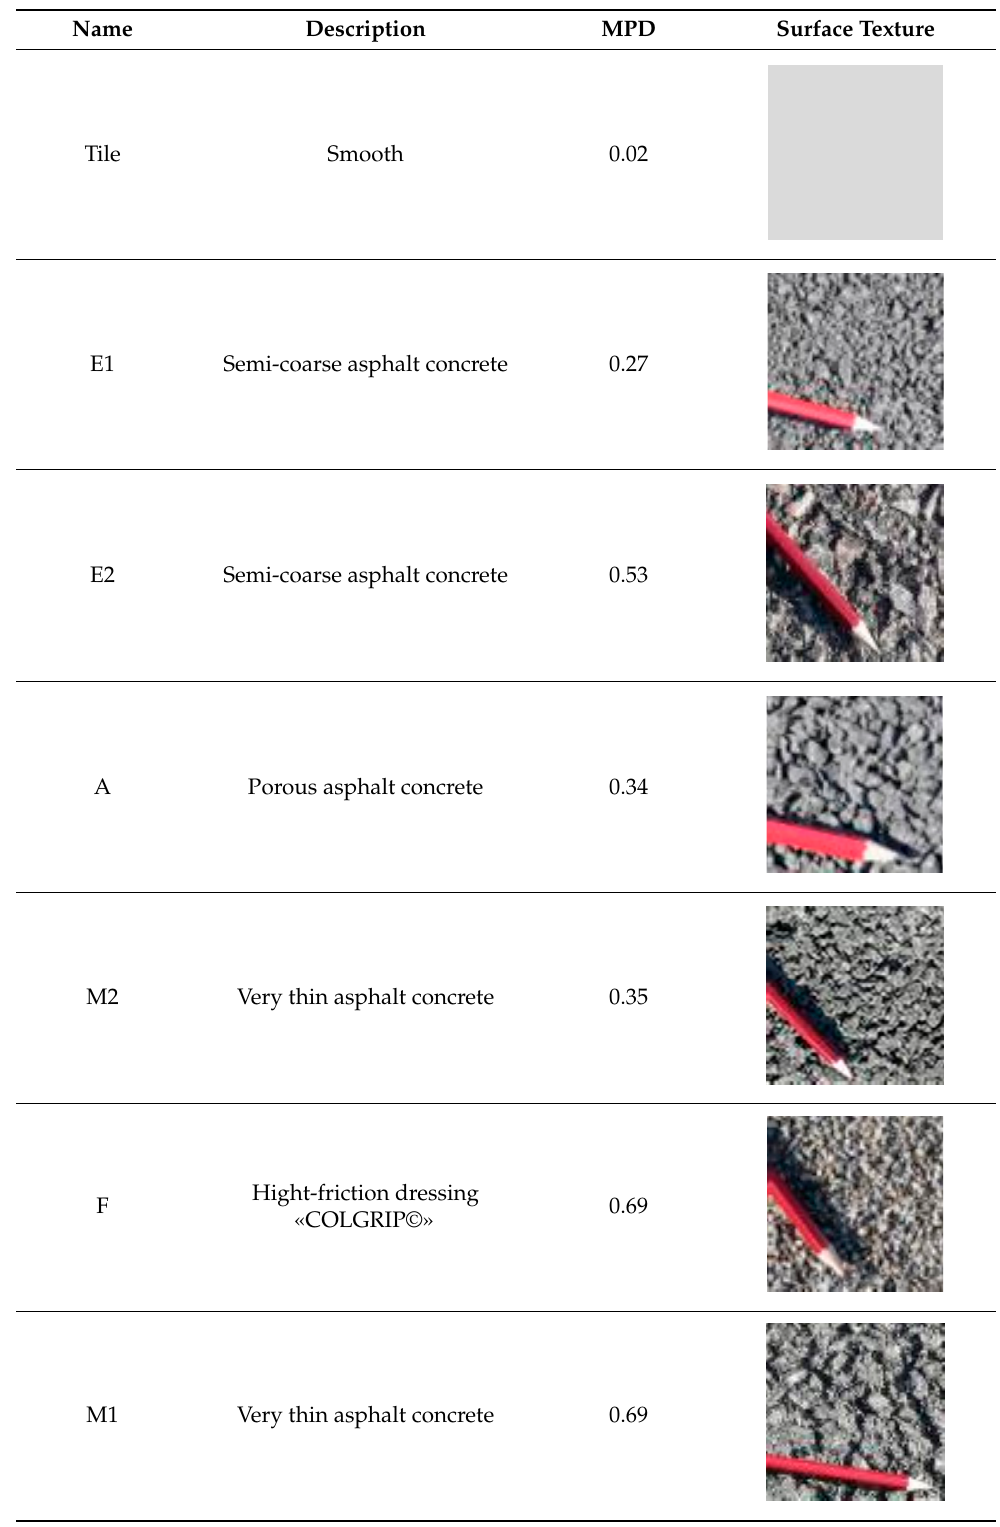
Table 1. Test surfaces and their